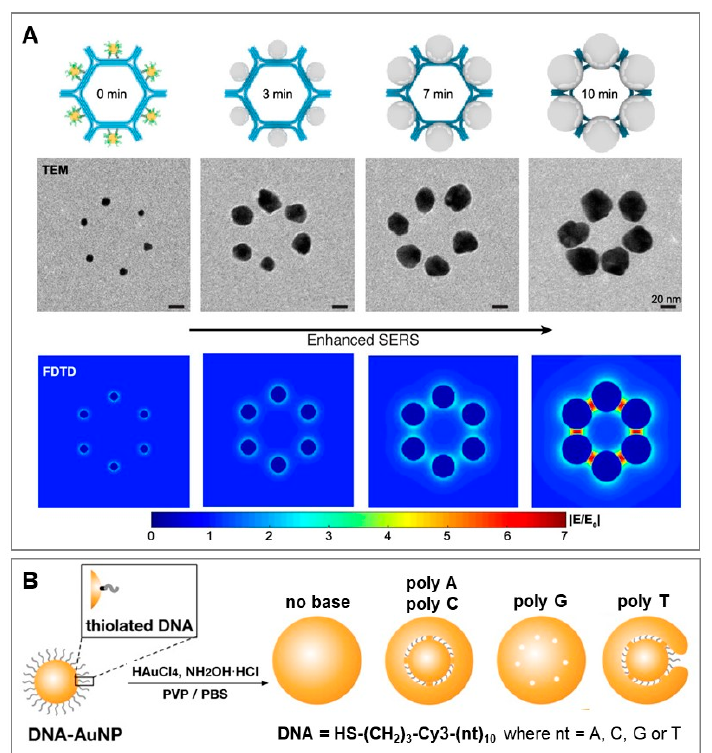
Figure 5. ( A ) Schematic of the fabrication of Ag@Au hexagonal metamolecules on a DNA origami template via control of the growth time of in situ silver deposition (t = 0, 3, 7 and 10 min). At t = 12 min, fusion of the nanoparticle was observed. Representative TEM images and corresponding finite-difference time-domain simulations of the electromagnetic fields (laser = 633 nm) are also included. Adapted with permission from [67]. Copyright 2021, American Chemical Society. ( B ) Out- line of the fabrication of core-shell SERS encoded nanoparticle with ultrasmall interior nanogap by exploiting thiolated DNA-based chemistry. The sequences of the thiolated ssDNA poly A, poly C, poly G and poly T are 3 (cid:48) -HS-(CH 2 ) 3 -(Cy3)-A 10 -5 (cid:48) , 3 (cid:48) -HS-(CH 2 ) 3 -(Cy3)-C 10 -5 (cid:48) , 3 (cid:48) -HS-(CH 2 ) 3 -(Cy3)- G 10 -5 (cid:48) , and 3 (cid:48) -HS-(CH 2 ) 3 -(Cy3)-T 10 -5 (cid:48) , respectively (where Cy3 = SERS code). “No base” refers to a structurally analogous thiolated ssDNA from which nucleobases were removed while leaving sugar moiety and phosphate backbone intact. Core-shell nanoparticles with nanometric interior gaps originated from DNA-modified gold cores in phosphate buffer saline (PBS) solution with polyvinylpyrrolidone (PVP) as a stabilizer. The reduction of HAuCl 4 onto the core was performed us- ing hydroxylamine hydrochloride (NH 2 OH · HCl) as a mild reducing agent. Adapted with permission from [68]. Copyright 2021, American Chemical